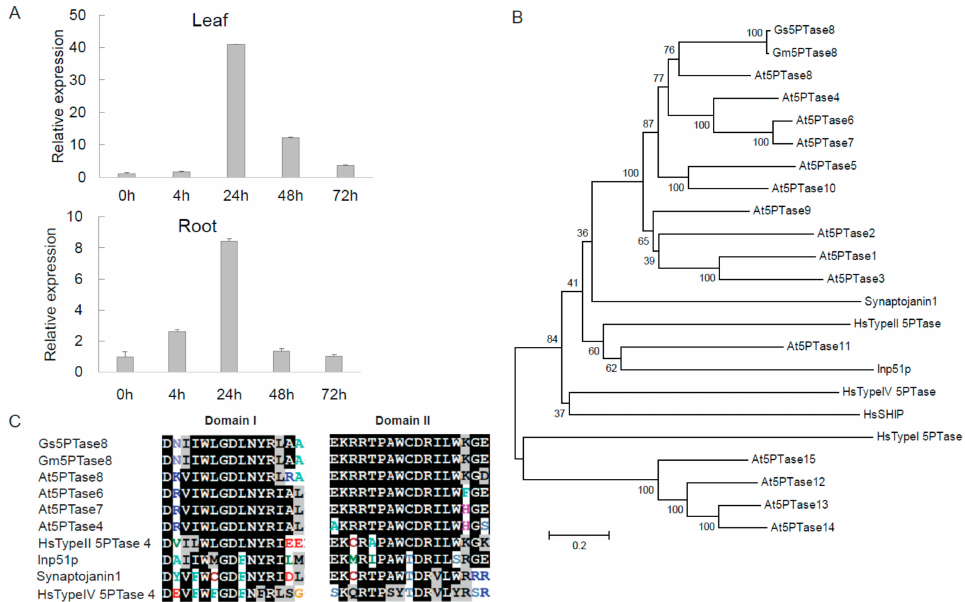
Figure 1. Gs5PTase8, a putative inositol polyphosphate 5-phosphatase, is induced by